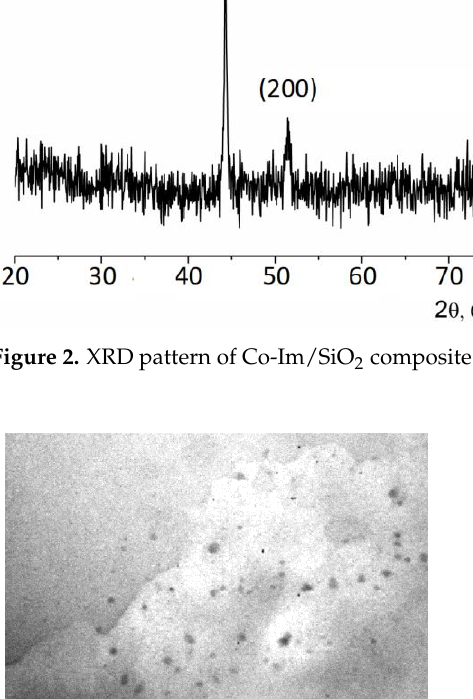
Figure 2. XRD pattern of Co-Im/SiO 2 composite.